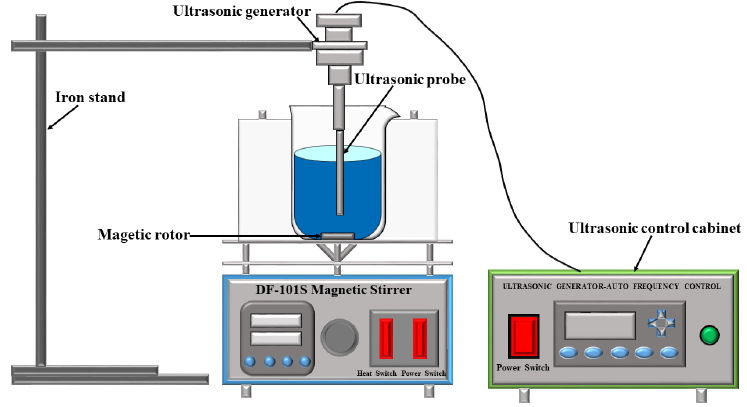
Figure 2. The experimental ultrasonic equipment is shown in the diagram.